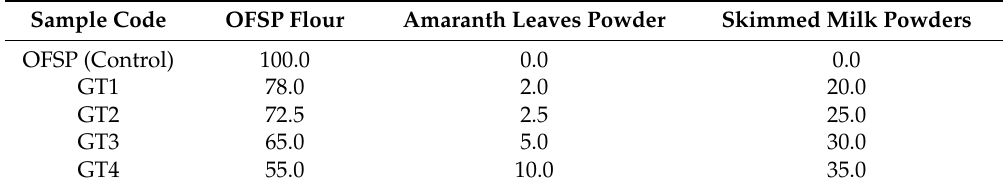
Table 1. Different proportions (%) of OFSP, amaranth leaves and skimmed milk powders used in composite